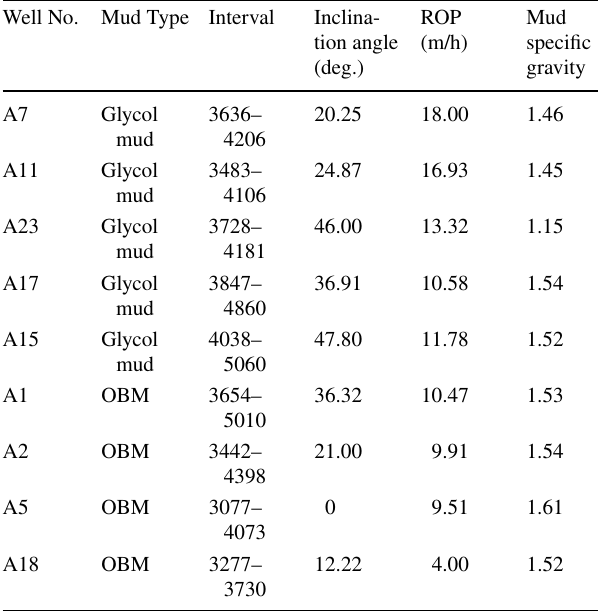
Table 6 Drilling program for